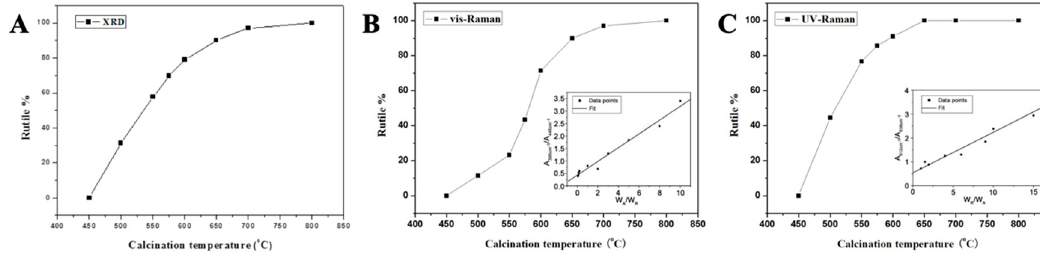
Figure 3. Weight percentage of the rutile phase in the TiO 2 nanofibers calcined at different temperatures estimated by ( A ) XRD, ( B ) visible Raman (the inset shows the area ratio of the anatase phase to the rutile phase [32]), and ( C ) UV Raman spectroscopy (the inset shows the area ratio of the rutile phase to the anatase phase [32]).